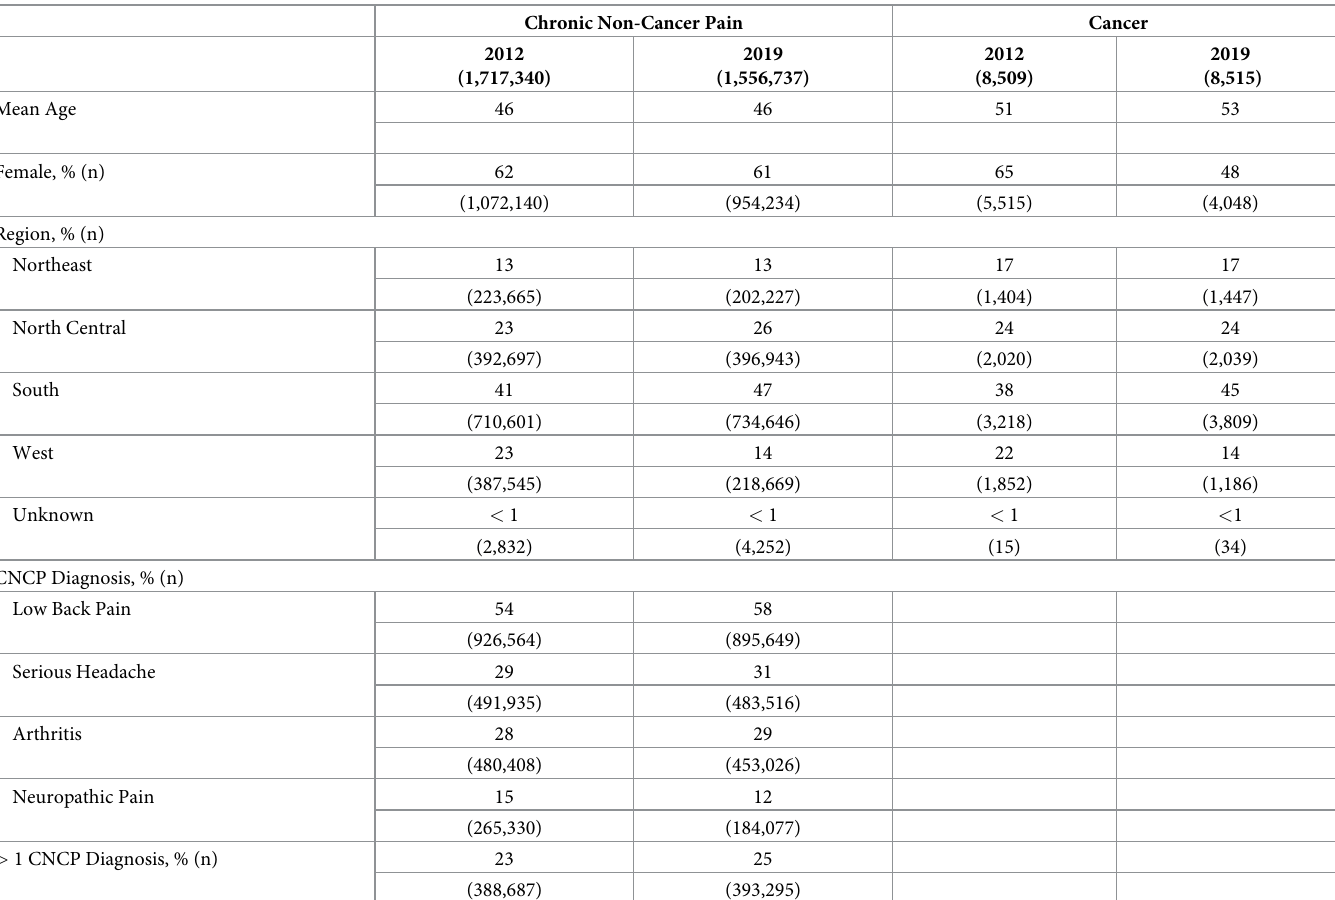
Table 1. Characteristics of individuals with chronic non-cancer pain (CNCP) or cancer,